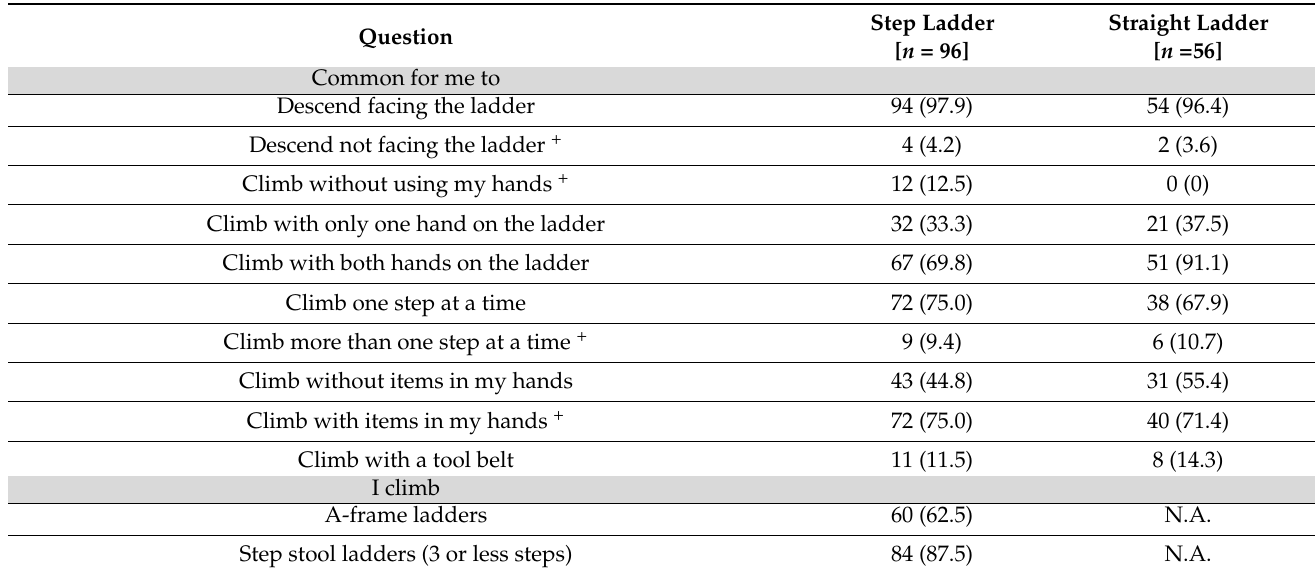
Table 2. Number (%) of participants who reported “yes” in relation to their use of step, straight, and fixed